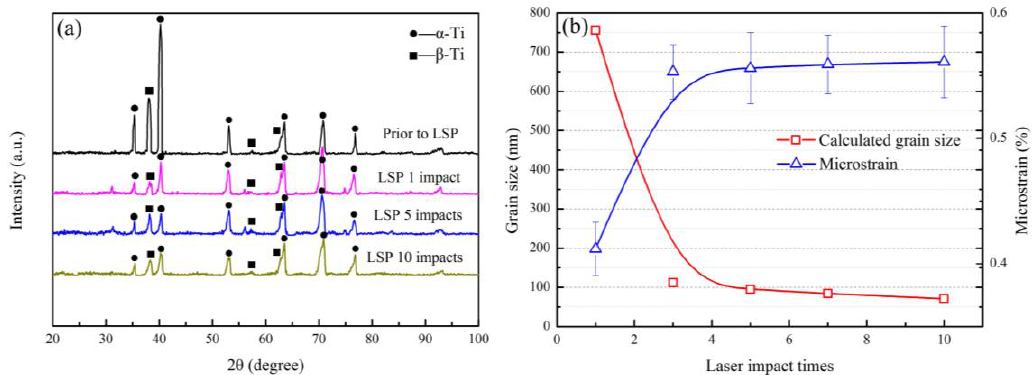
Figure 3. ( a ) The XRD patterns of the Ti-6Al-4V alloy before and after LSP. ( b ) Grain size and micro-strain evolution after the multiple laser peening.